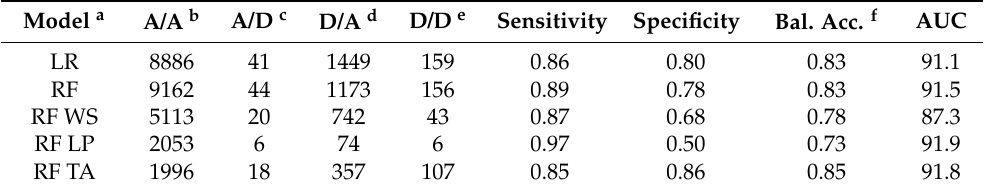
Figure 4. Examples of correct and incorrect classifications of each species (LP = lodgepole pine, WS = white spruce, TA = trembling aspen) for tree crowns outlined in red. True positives are trees that were correctly predicted to survive; true negatives are trees that were correctly predicted to die; false positives are trees that were predicted to survive, but actually died; false negatives are trees that were predicted to die, but actually survived. Table 2. Classification results and goodness-of-fit statistics for the logistic regression and random forest